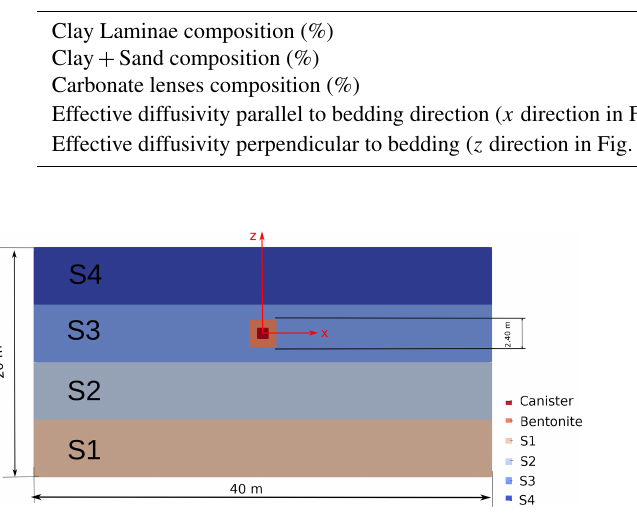
Table 1. Subfacies compositions and the effective diffusivities of four structures of SF-OPA. The compositions are quantified using µ -CT segmentation. The effective diffusivities are calculated using an upscaling workflow and digital rock models. Structure